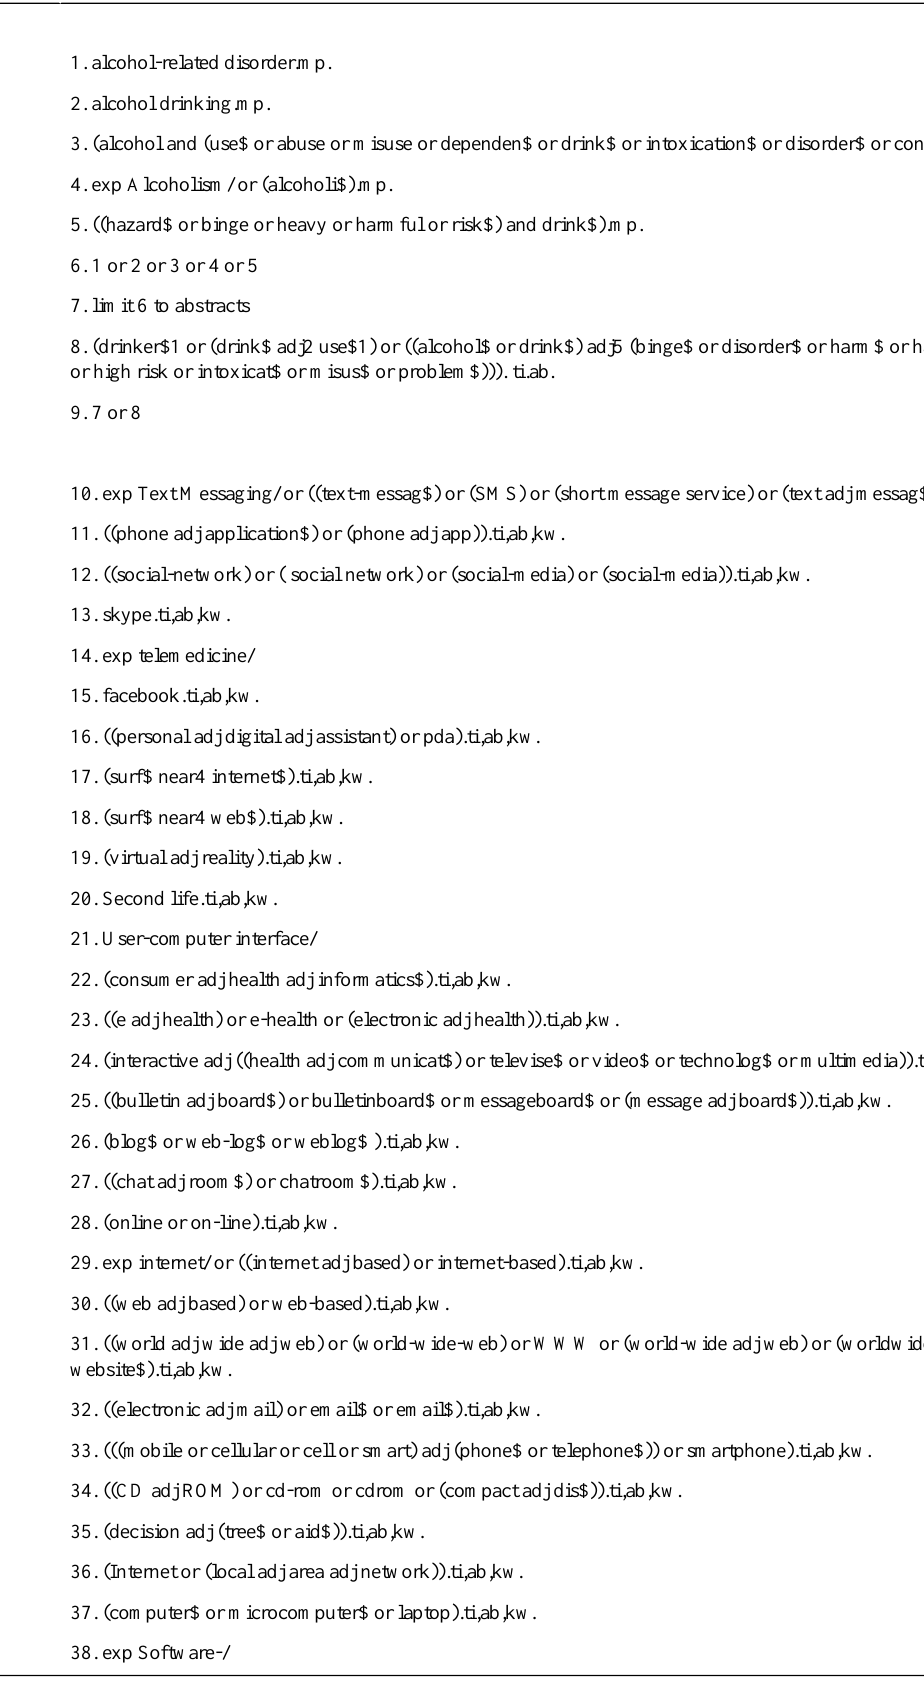
Search termsSearch term